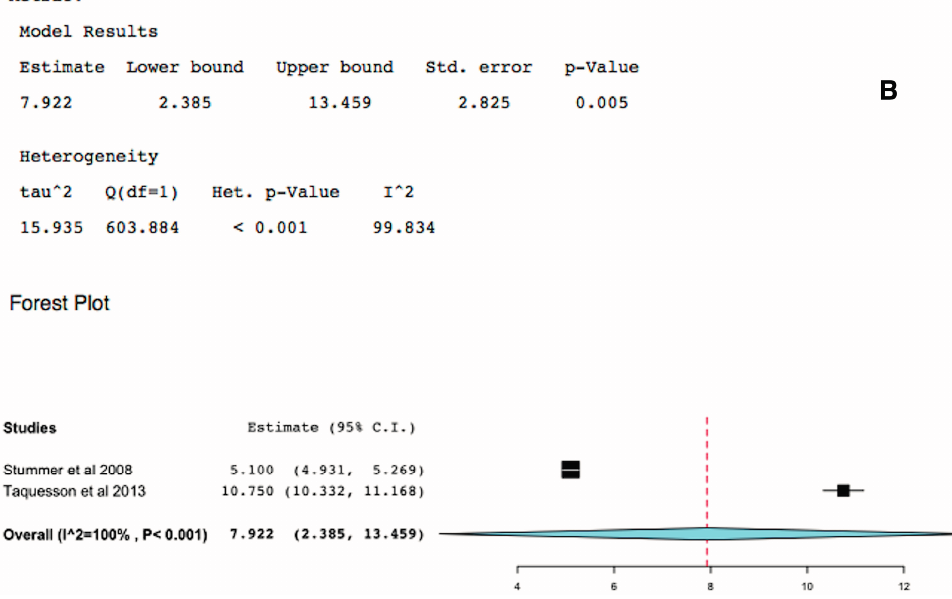
Figure 3. Forest plot (meta-analysis) and heterogeneity of 5-ALA-FIGR time to tumor progression (TTP). ( A ) excludes study [15] and ( B ) includes it, because study [15] had repetitive PDT (rPDT) in addition to 5-ALA-FIGR. (Squares represent the mean, the bigger the square is the more weight given because of the narrower 95% CI, the diamond represent the mean in the combined data in the